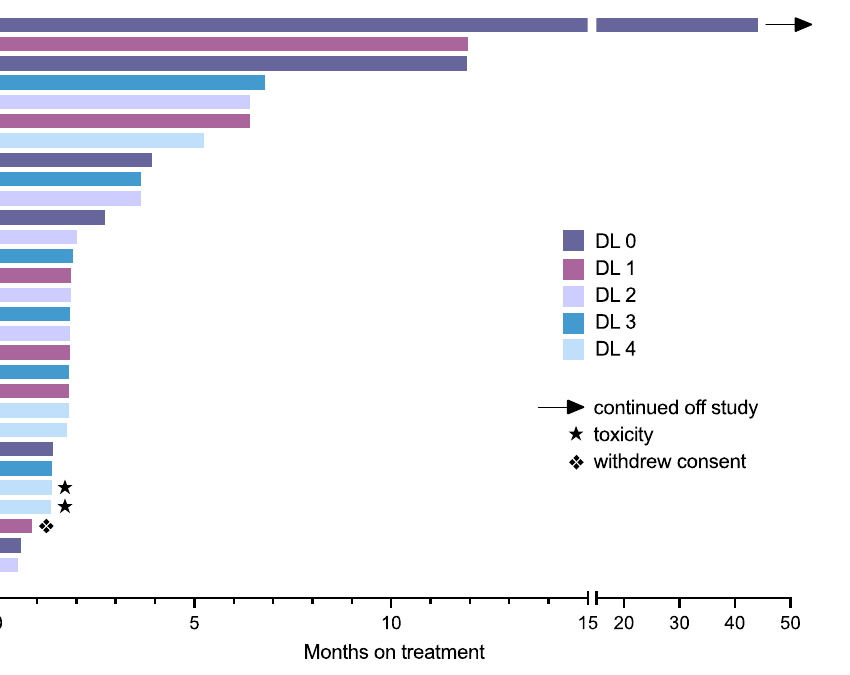
Figure 2. Swimmer’s plot for patients in the study. Except where indicated, all patients discontinued therapy due to progressive disease. Dose level (DL) for each patient as indicated.